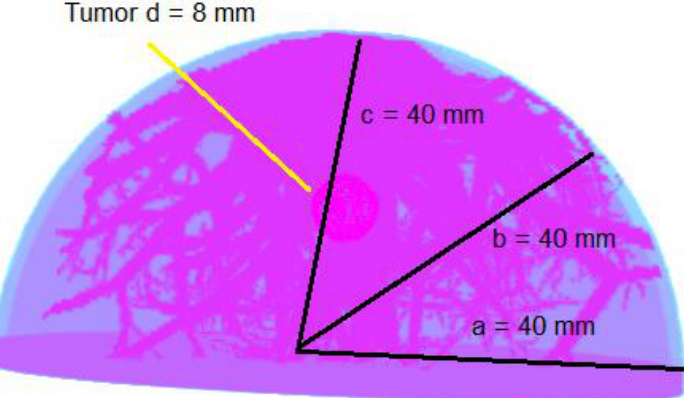
Figure 1. The anthropomorphic breast phantom with an 8 mm diameter tumor. To simulate a clinical examination for breast cancer in the prone position, a half-ellipsoidal anthropomorphic breast phantom is used as an approximation of the realistic breast [20,21]. The phantom consists of ductal networks, adipose tissues, glandular tissues, skin, and the lesion placed in the center of the breast phantom, as shown in Figure 1. The atomic compositions of all breast tissues were taken from ICRUP report 44 [22]. The simulated geometrical structure developed using GATE is given in Figure 2. The proper shielding with high-density material near 100% attenuation towards simulated particles at a given energy is very important, otherwise, the image reconstruction may suffer degradation due to false counts. The tungsten material of 1.5 mm thickness is used for shielding the mask as well as the detector to stop the uncollimated radiations. The patient is kept in a chamber where the only breast part is visible out of the chamber for radiation emission. In this way, the whole body of the patient is shielded except the breast, but there are still radiations coming out from the chest just behind the breast. Although, the background radiations’ contribution is very important, which should be addressed in the imaging process rather than the reconstruction process. In this paper, we are only providing the proof of concept that the 3D reconstruction of the breast phantom is possible with coded-aperture imaging. Therefore, only the breast is modelled for the simulation and adding the contribution of the chest and background will be the subject of future research. Right now, we are interested in reconstructing a 3D anthropomorphic breast phantom using a coded-aperture mask. Therefore, the radiations’ contribution other than the breast is eliminated and only radiations coming out from the breast are